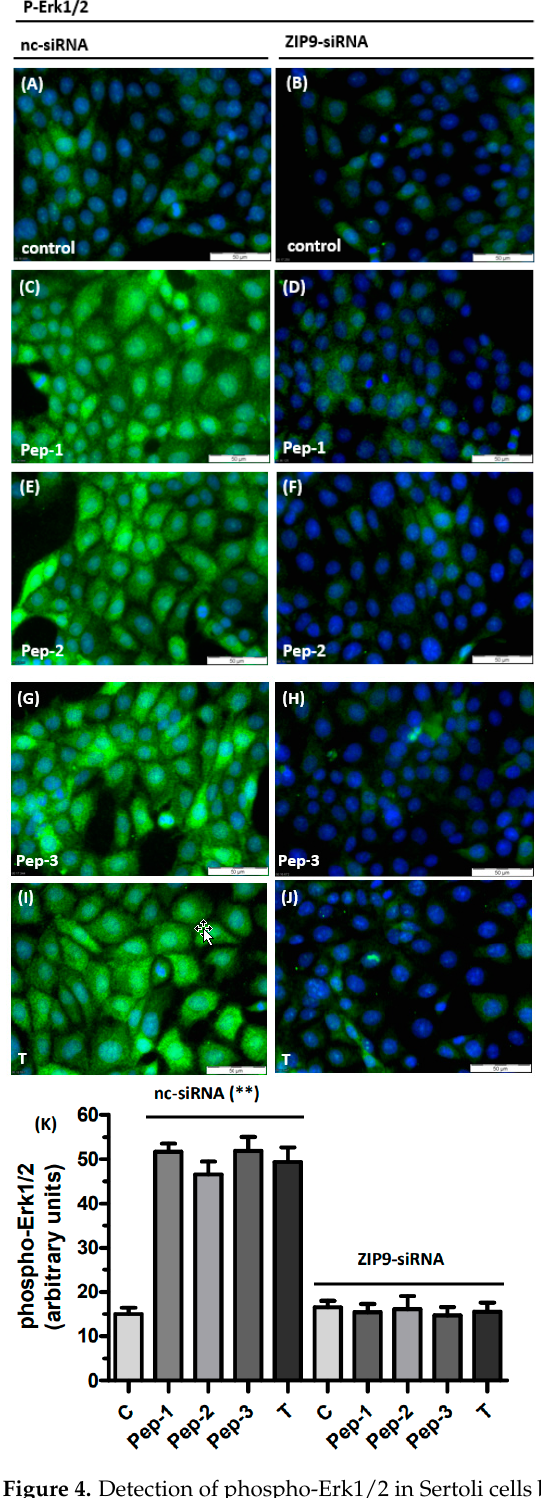
Figure 4. Detection of phospho-Erk1/2 in Sertoli cells by immunofluorescence. Incubation of 93RS2 cells with 10 nM of T or with 10 µM of each of the peptides occurred for 30 min. Nuclei are stained blue, phospho-Erk1/2 is represented by green fluorescence. Cells were treated either with negative control siRNA ( A , C , E , G , I ) or with ZIP9-directed siRNA ( B , D , F , H , J ). ( A ) Phospho-Erk1/2 in unstimulated Sertoli cells. ( C ) Phospho-Erk1/2 in cells treated with Pep-1, ( E ) treated with Pep-2, ( G ) treated with Pep-3 and ( I ) treated with T. When ZIP9 expression is silenced by siRNA peptides or T fail to stimulate Erk1/2 phosphorylation ( B , D , F , H , J ). ( K ) Statistical analysis of green fluorescence shown in panels A-J (n = 3 × 25; means ± SEM; ** p ≤